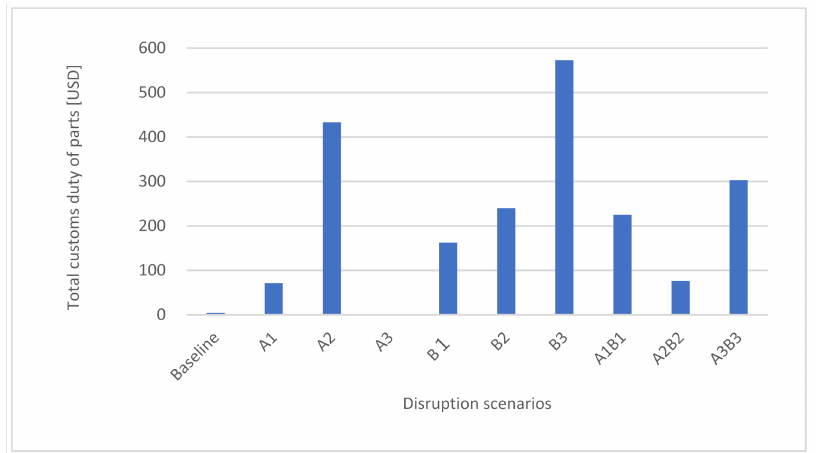
Figure 12. The total customs duty of parts in all